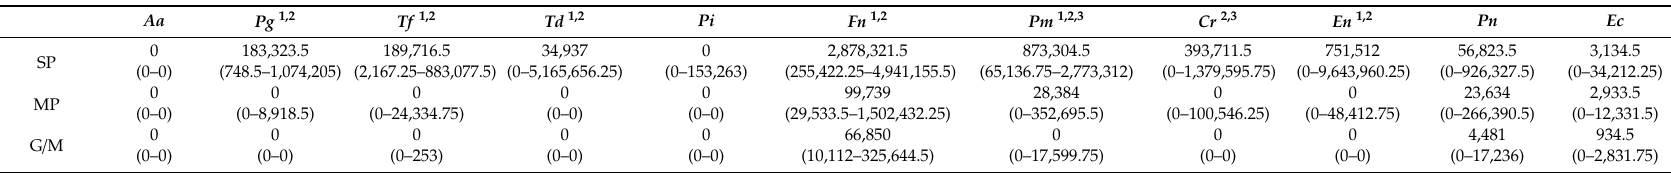
Table A1. Bacterial DNA counts of target bacteria in paperpoint samples of di ff erent study groups. Median values and interquartile ranges were summarized in the table.